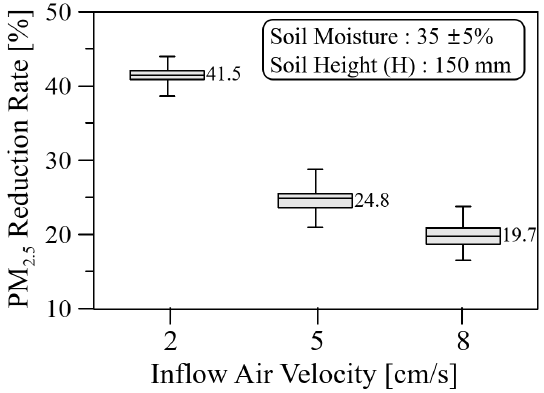
Figure 12. PM 2.5 reduction rate with respect to inflow air velocity for the soil height and moisture of 150 mm and 35 ± 5%, respectively.